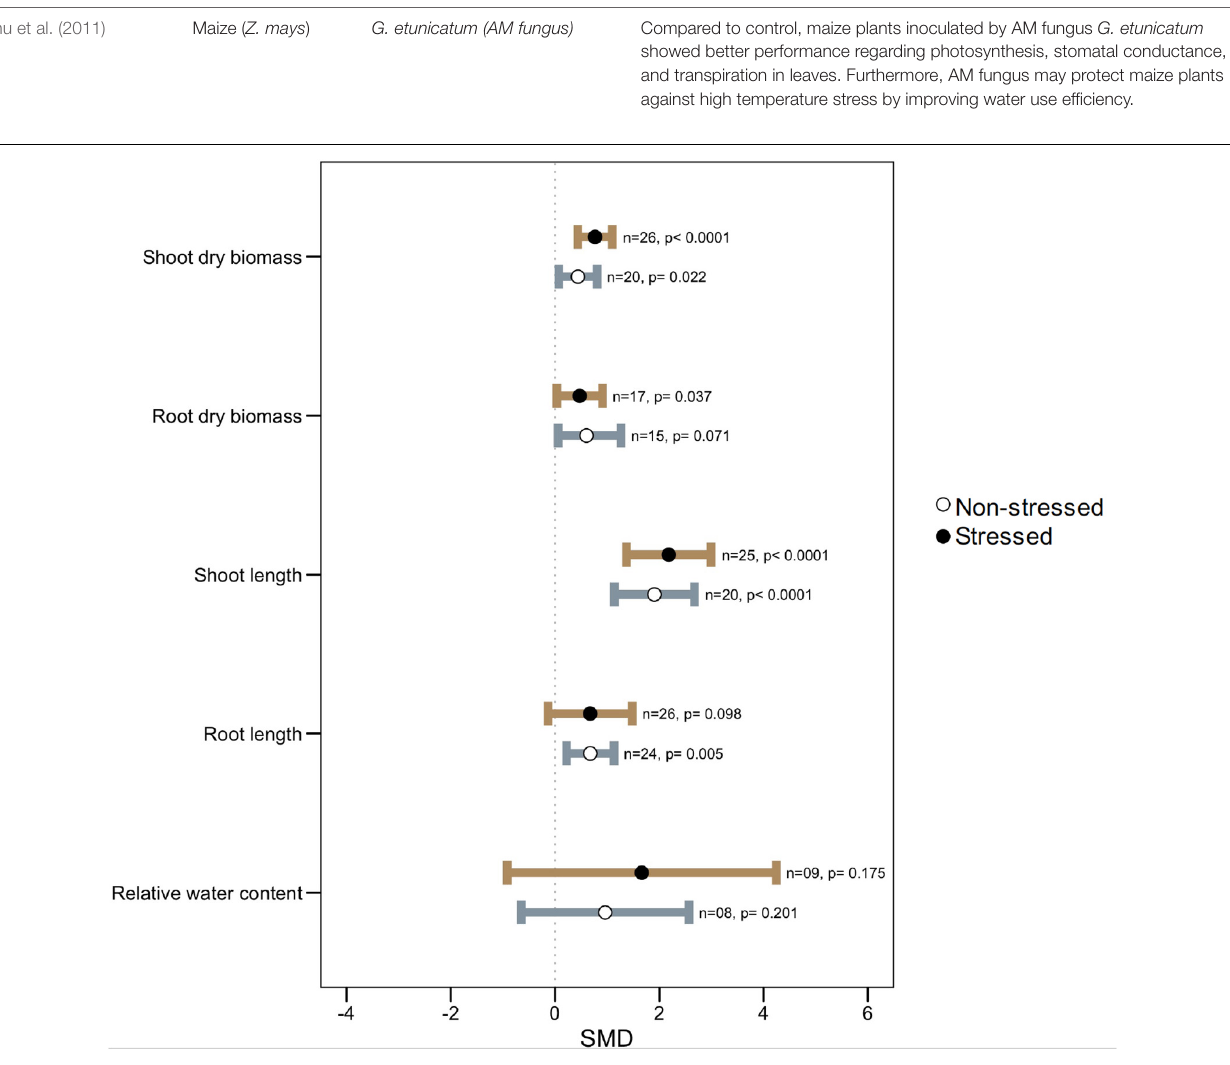
FIGURE 2 | Growth responses of microbe-inoculated plants compared with those of non-inoculated plants under heat stress and non-stressed conditions. Error bars are effect size (SMD) means ± 95% CIs. Where the CIs do not overlap the vertical dashed lines, the effect size for a parameter is significant, i.e., the growth responses of inoculated plants were significantly different from those of non-inoculated plants. n = number of studies included in the meta-analysis, p = significance level of